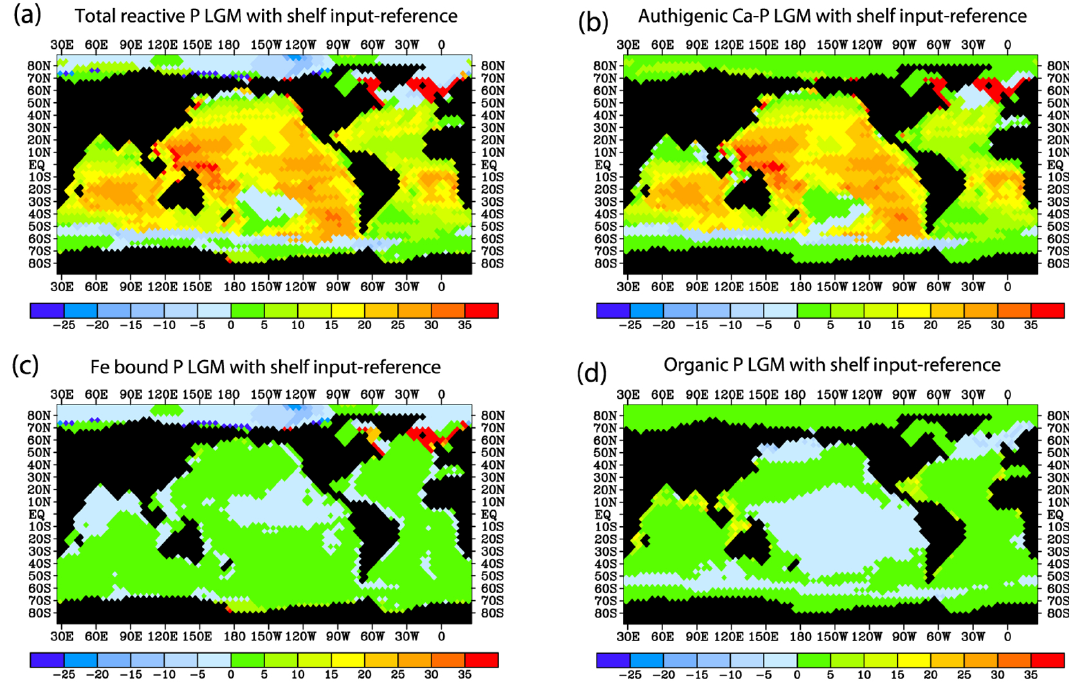
Fig. 10. As for Fig. 7 but for the LGM simulation with shelf input. Note the different color scale relative to Fig. 7. Units in µmolPg − 1